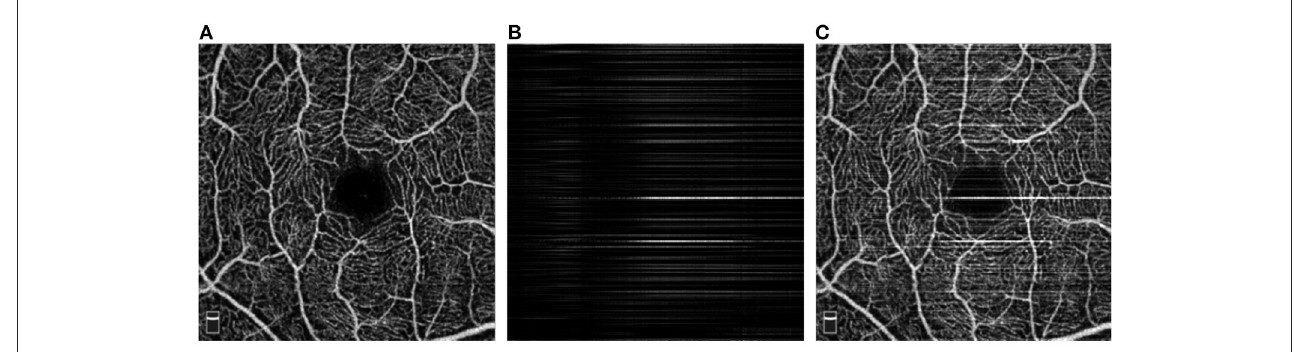
FIGURE5 Illustration of paired OCTA images in PUTH dataset. (A) Clean image; (B) Stripe noise at noise level i = 2 generated by Wu et al. (18); (C) Stripe noise in (B) added on (A) .